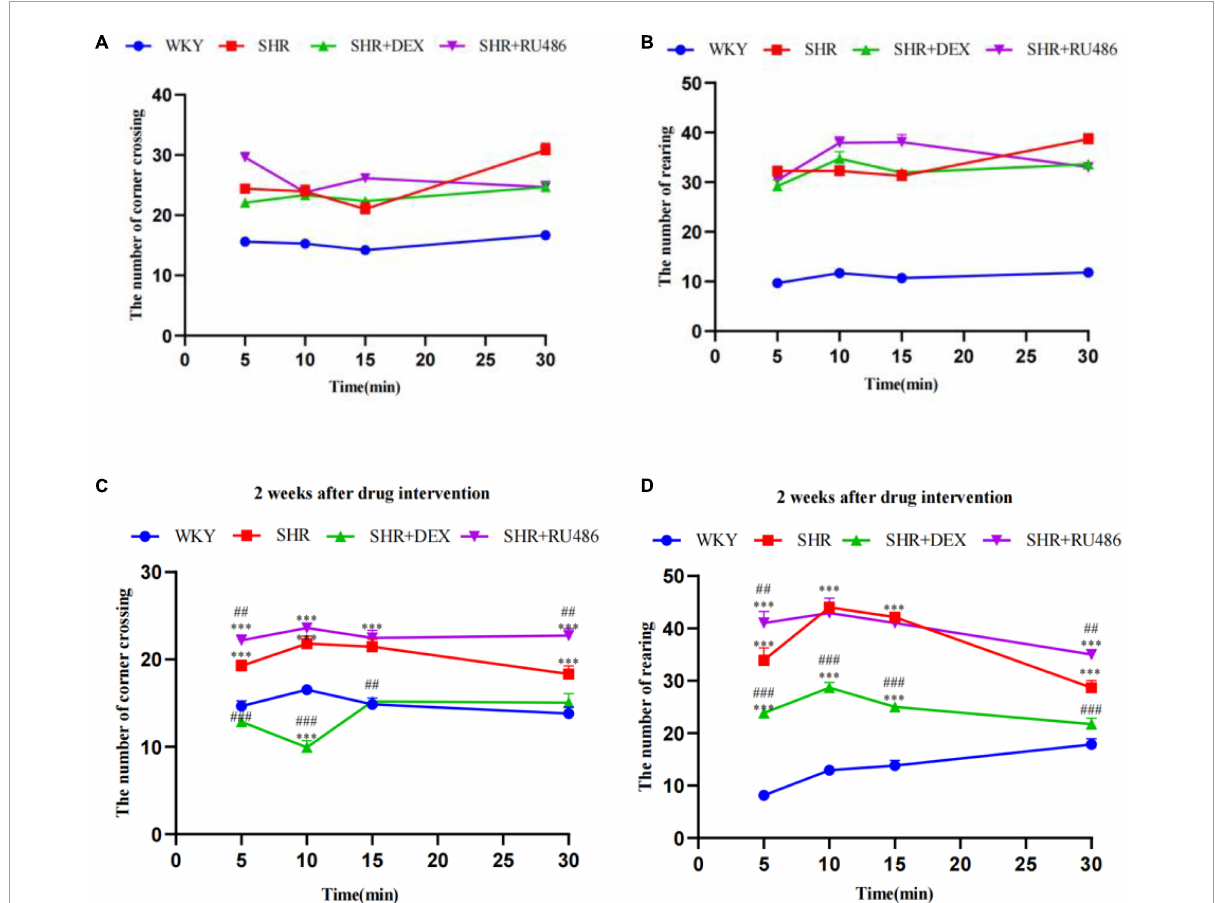
FIGURE3 Behavioral performance in Làt maze ( n = 15 in each group). (A) The number of corner crossings before drug intervention, (B) the number of rearings before drug intervention, (C) the number of corner crossings after drug intervention for 2 weeks, (D) the number of rearings after drug intervention for 2 weeks. One-way analysis of variance (ANOVA) with repeated measures followed by post hoc with Tukey test. All data are presented as mean ± SEM. ∗∗∗ p < 0.001, compared to Wista Kyoto rats (WKY) group; ## p < 0.01, ### p < 0.001, compared to spontaneously hypertensive rats (SHR)